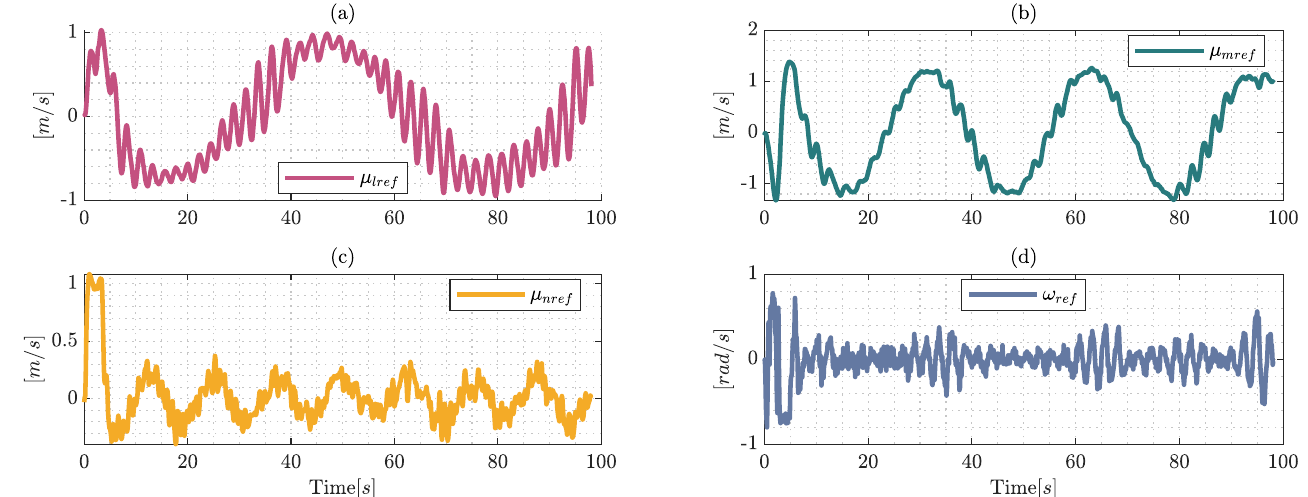
(cid:8) (cid:9) I y ;